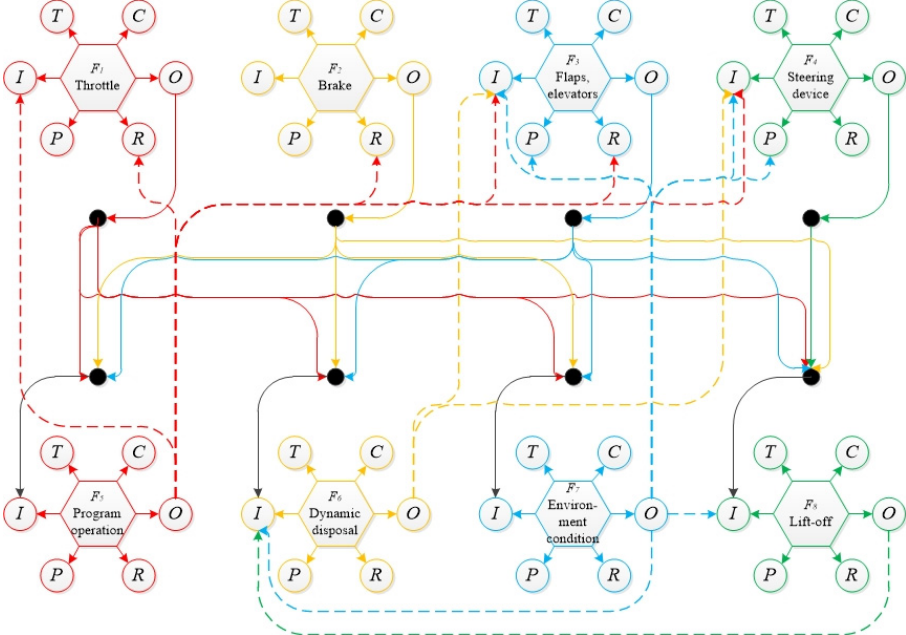
Figure 6. Take-off stage functional network.